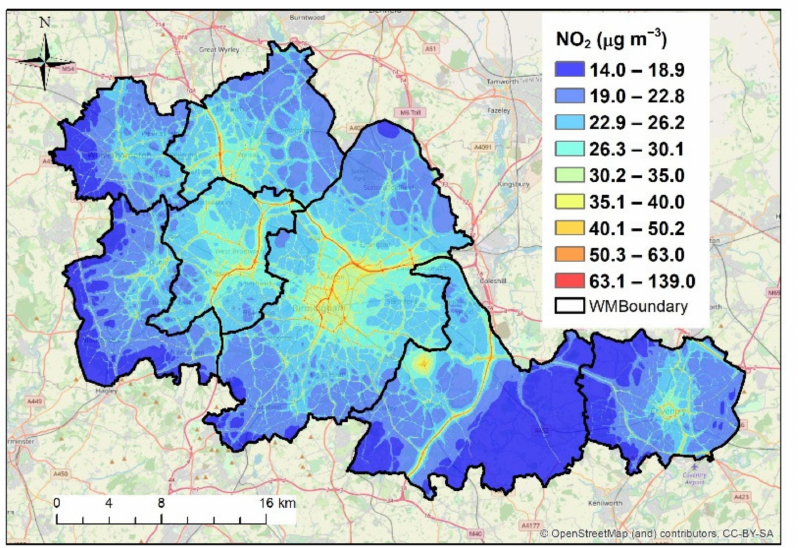
Figure 7. Annual air quality maps for NO 2 (in µ g m − 3 ) at 10 m × 10 m resolution. Areas exceeding the UK objective value of 40 µ g m − 3 are shown in yellow, orange and